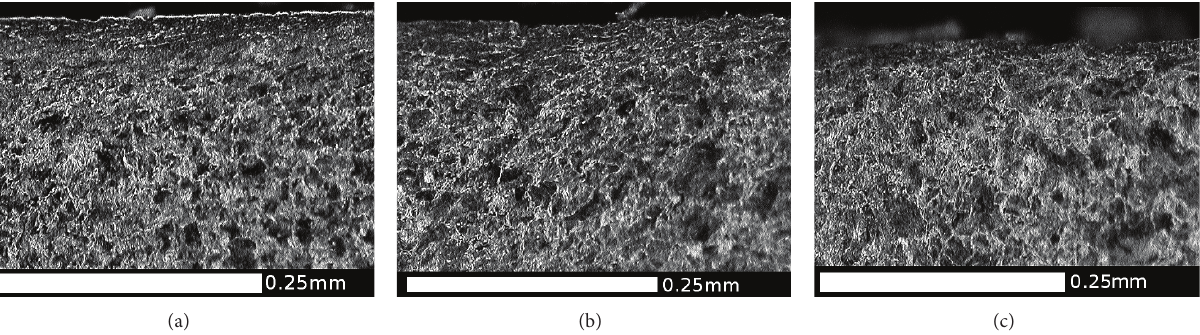
Figure 14: OM images of microstructure in the running band (centre of the tread): (a) Region D1, (b) Region D2, and (c) Region D3. The tangential forces are generally lower in this region and typically circumferential (normal to these sections). There is no obvious shearing of the microstructure